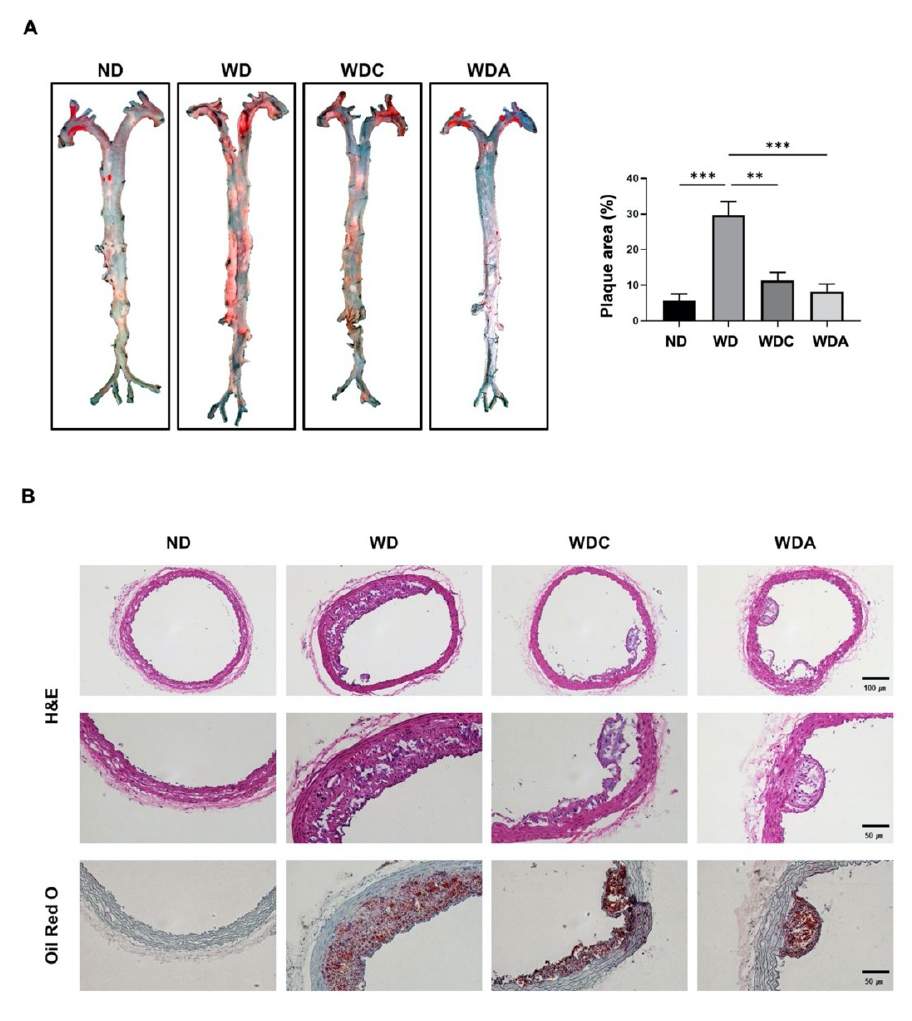
Figure 2. Capsanthin inhibited plaque formation in the aorta of Western-type diet (WD)-fed apolipoprotein E deficient (ApoE −/− ) mice. ( A ) Whole aortas were stained with oil red O for the observation of lipid accumulation (red). Representative images of the aorta from each group (left). Quantification of the plaque area as a relative percentage of the oil red O-positive area in total area using image J software (right). All values represent the mean ± SEM ( n = 3). ** p < 0.01, *** p < 0.001 vs. WD group. ( B ) Representative photomicrographs for cross-sectional aortas of H&E or oil red O-staining from the thoracic aortic from each group in ApoE −/− mice. H&E images indicate ×10 magnification (upper, scale bar, 100 μ m) and ×20 magnification (bottom, scale bar, 50 μ m). Cross-sectional aortas were stained with Oil Red O and counterstained with hematoxylin. Oil red O-stained aorta images show ×20 magnification (scale bar, 50 μ m). ND; normal diet, WD; Western-type diet, WDC; capsanthin with Western-type diet, WDA; atorvastatin with Western-type diet.